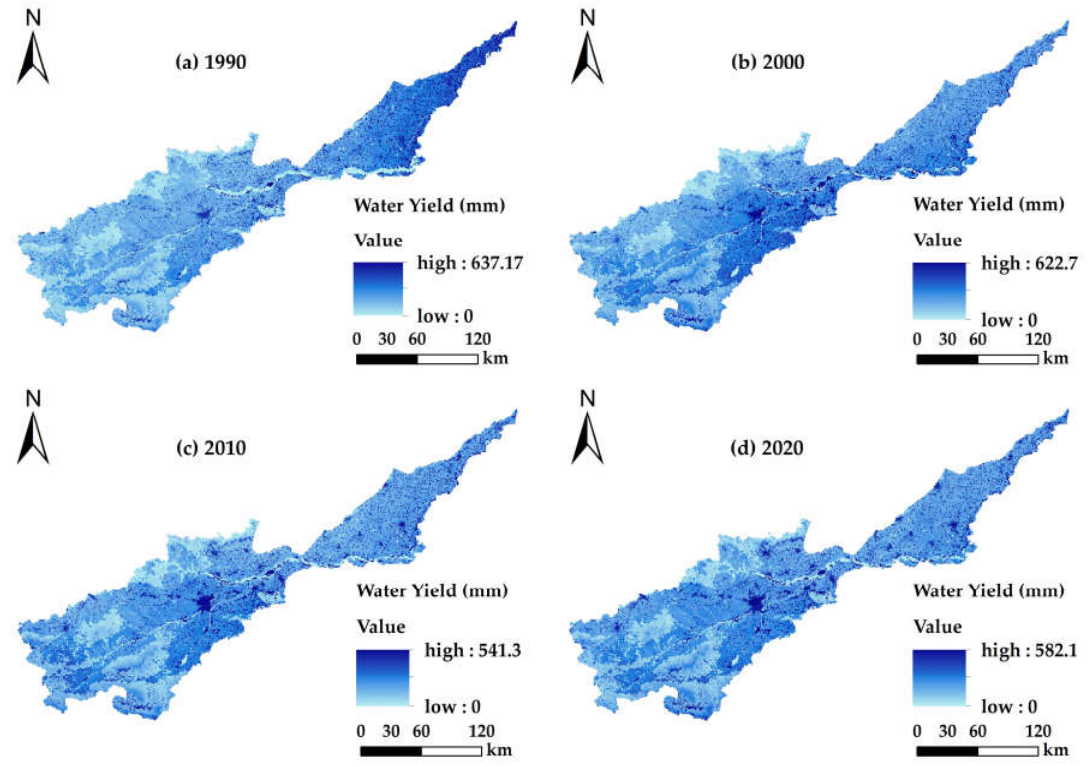
Figure 4. Spatial distribution for the depth of the water yield for the Yellow River Basin (Henan section): ( a ) water yield map for 1990; ( b ) water yield map for 2000; ( c ) water yield map for 2010; ( d ) water yield map for 2020. Table 4. Soil conservation of various land use types for the Yellow River Basin (Henan section) from 1990 to 2020 (10 8